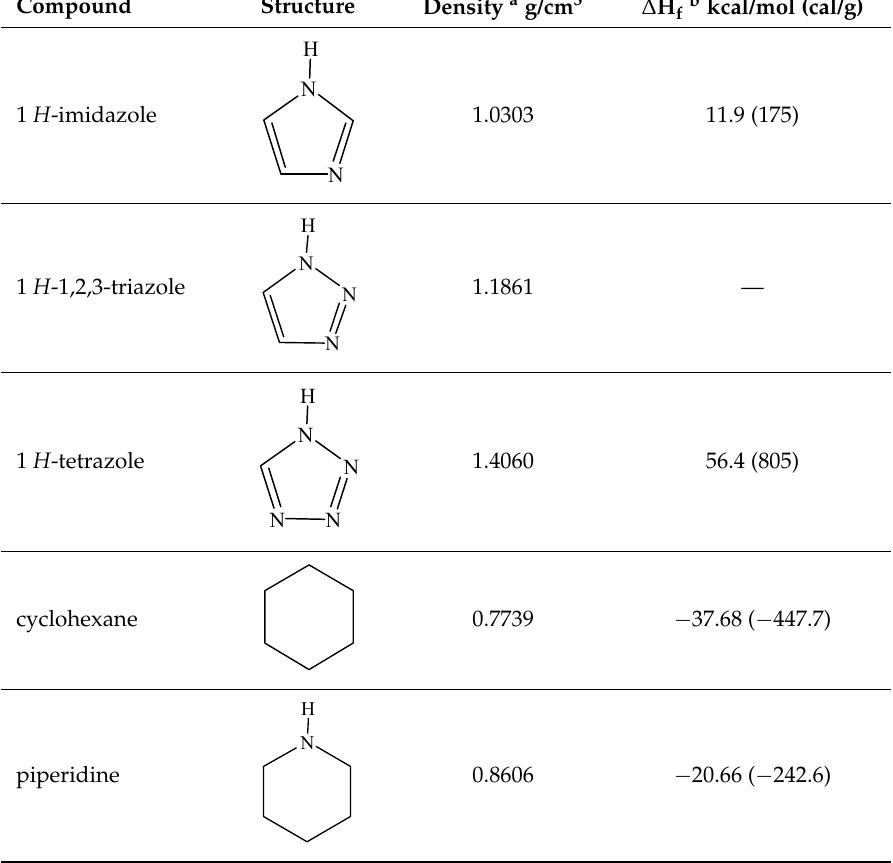
Table 4. Some experimental densities and heats of formation, Δ H f .